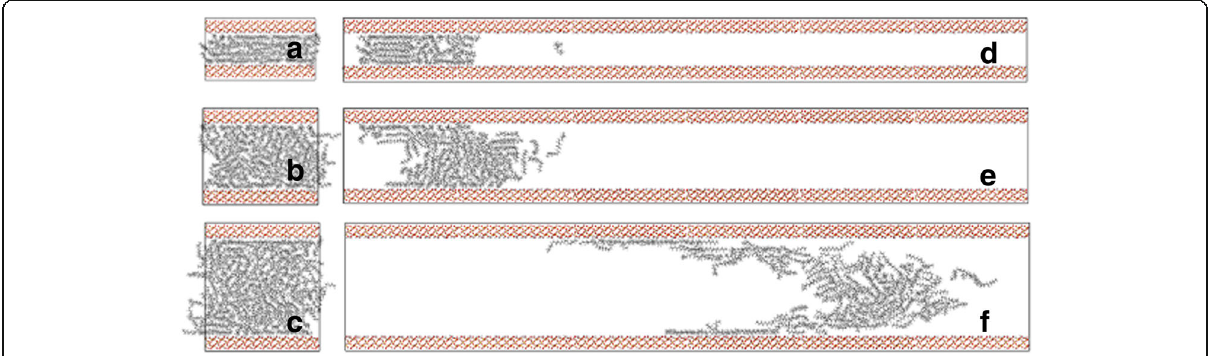
Fig. 2 The initial model of force-driven octadecane molecules transportation process in silica channels with widths of a 2, b 4, and c 6 nm, and snapshots of octadecane molecules in d 2, e 4, and f 6 nm channels at 2